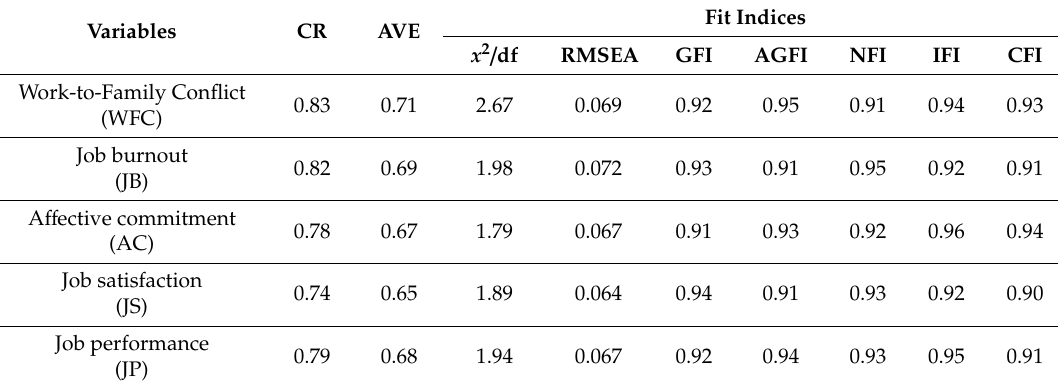
Table 3. Results of